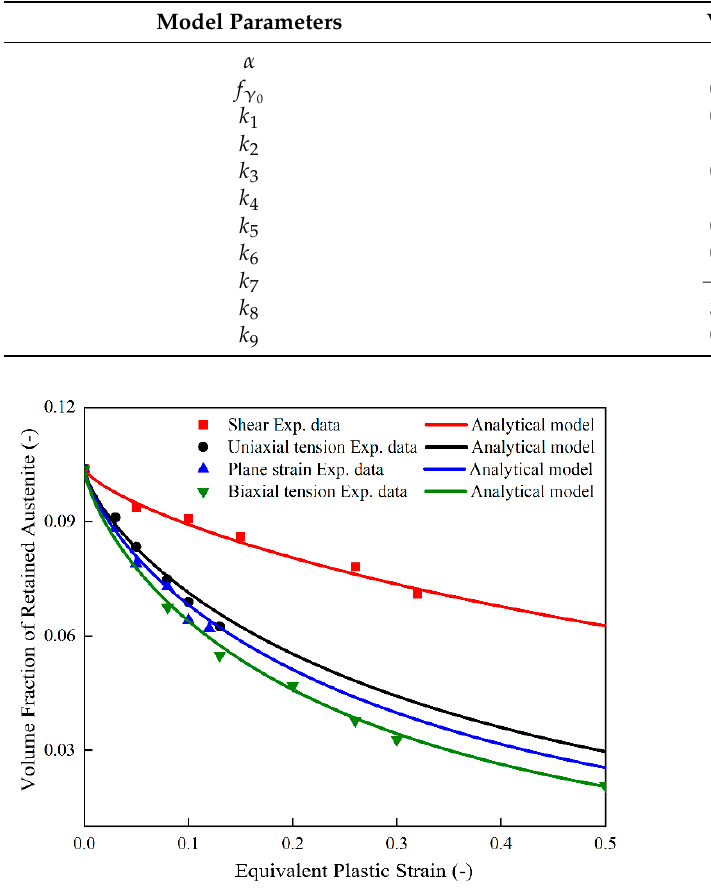
Figure 6. Comparisons of prediction results of austenite content evolution under different stress